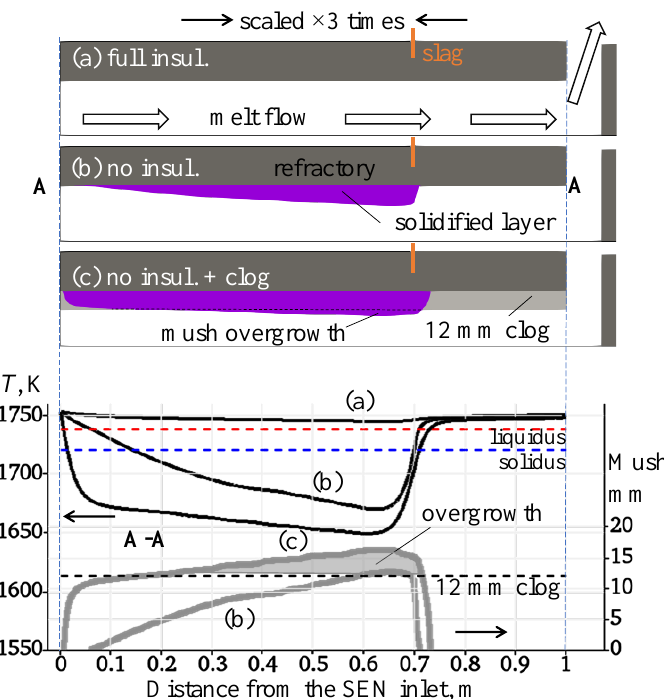
Figure 7. Solidified steel inside the SEN (top figures ( a )–( c )) and the temperature distribution/mush thickness along the SEN inner wall (line A-A): ( a ) insulation of the SEN with a fiber layer; ( b ) uninsulated SEN without the 12 mm clog layer; and ( c ) uninsulated SEN with the 12 mm clog layer.